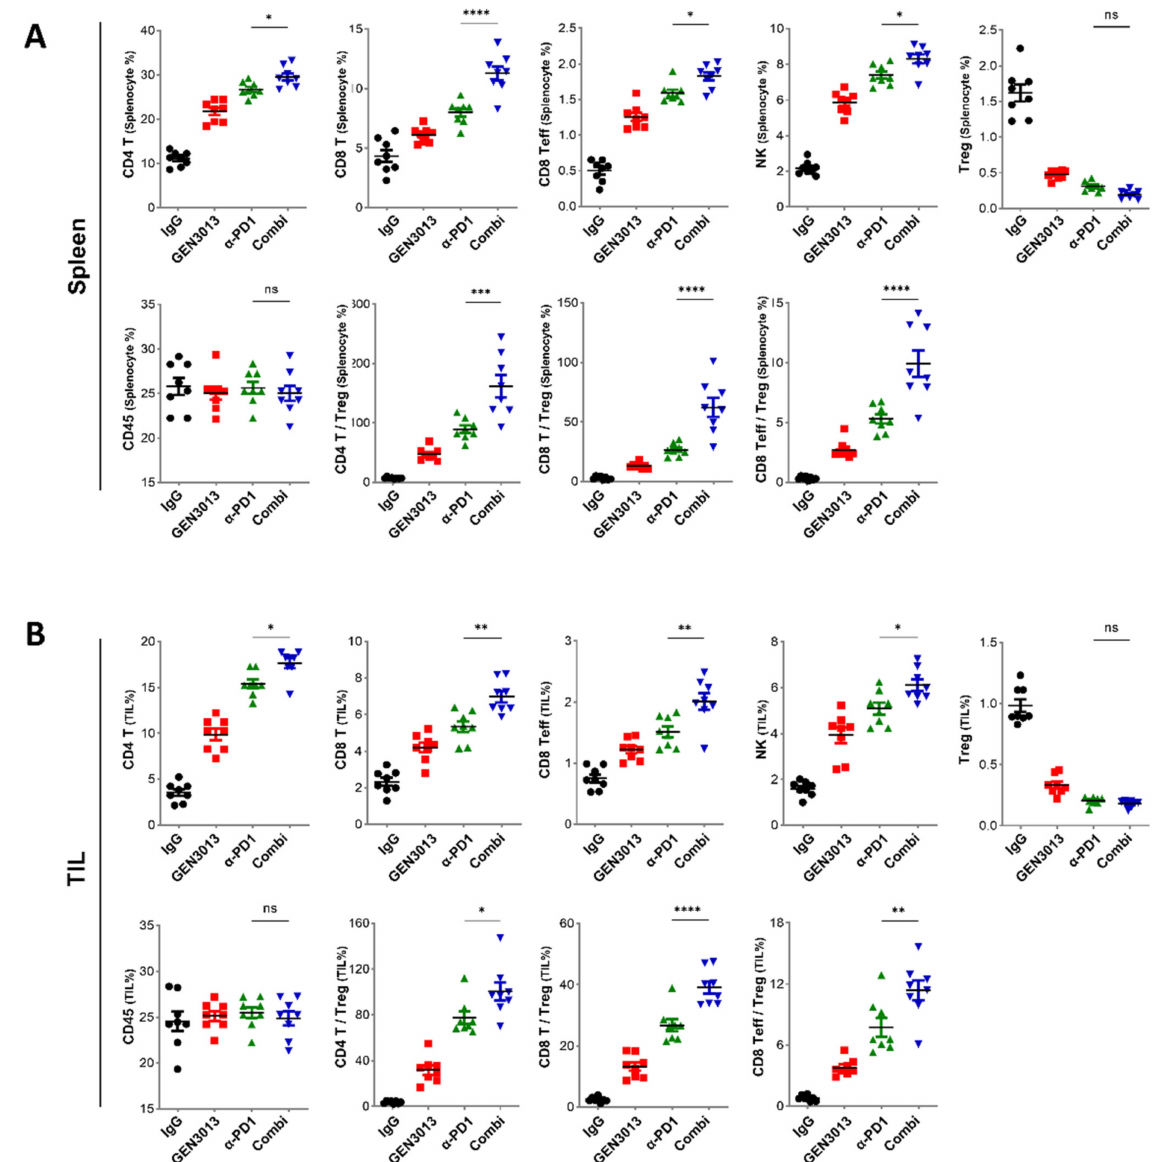
Figure 6. Combination of Lactococcus lactis GEN3013 and immunotherapy reprograms the